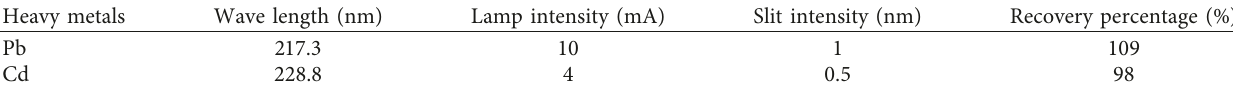
Table 2: Operating parameters and recovery percentages of atomic absorption spectrometer (AAS) for working